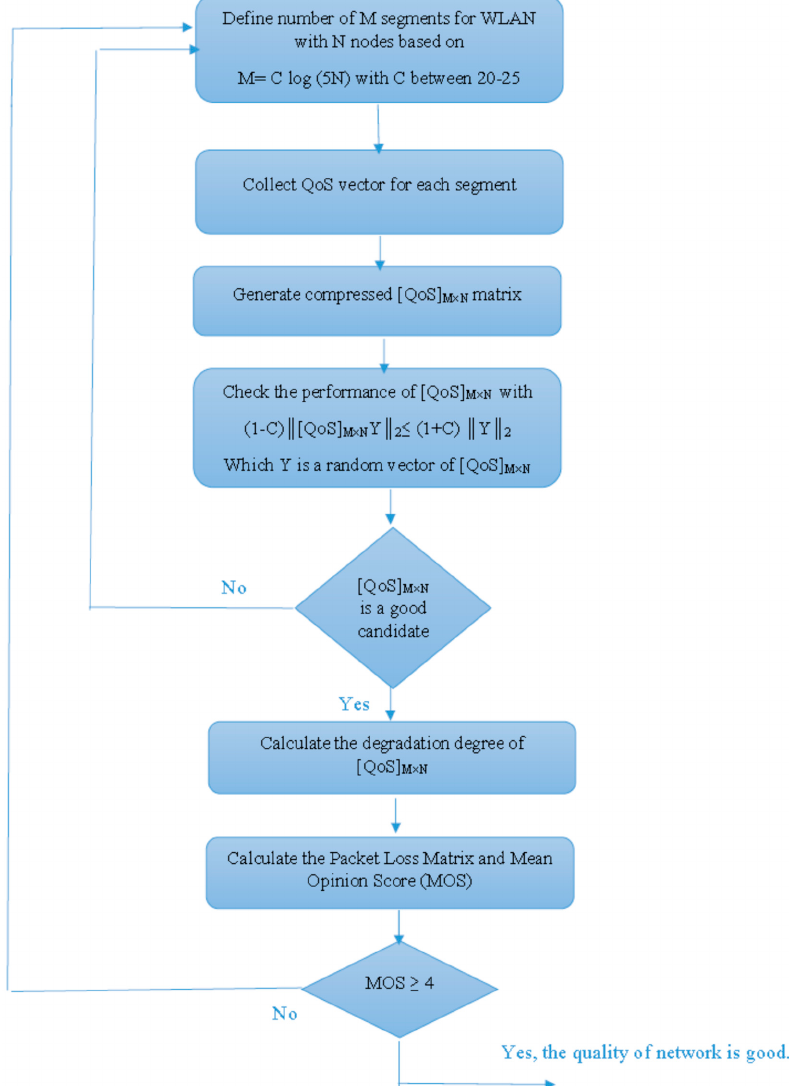
Figure 1. The proposed RTNTM algorithm.